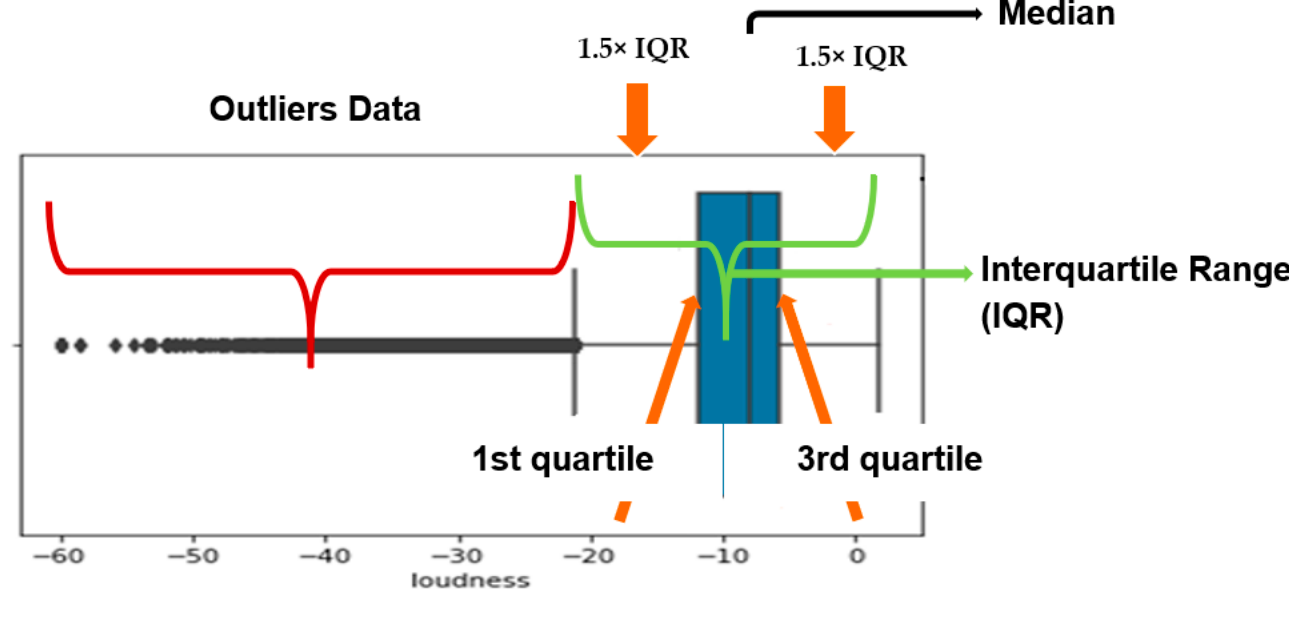
Figure 4. Loudness feature outlier data.